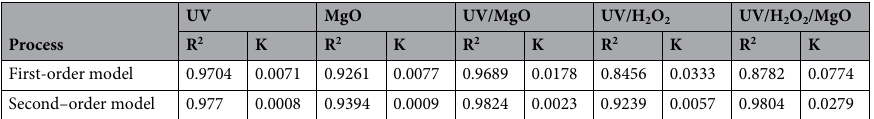
Table 2. The obtained coefficients of first and second order kinetic models for the removal of DEX by UV, MgO, UV/H 2 O 2 and UV/H 2 O 2 /MgO processes were